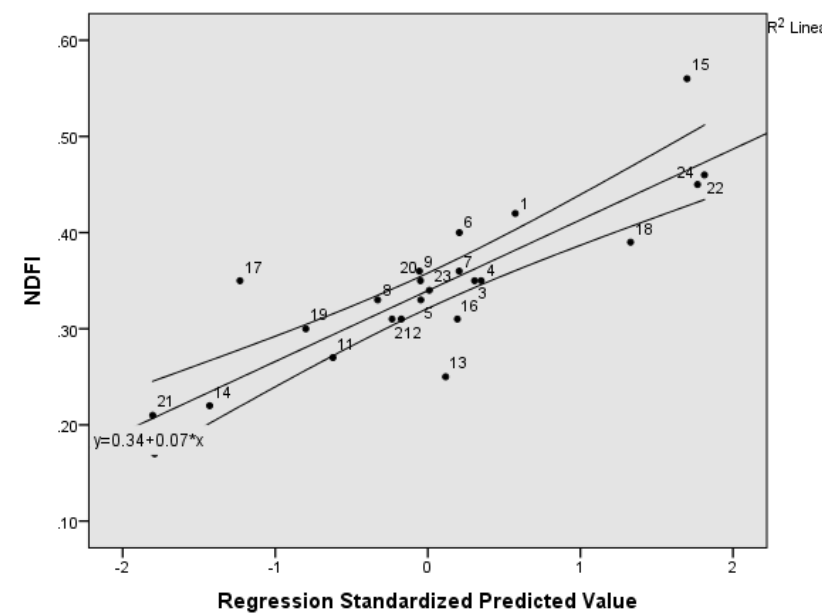
Figure 49. Relationship between regression ZPR and NDFI2.